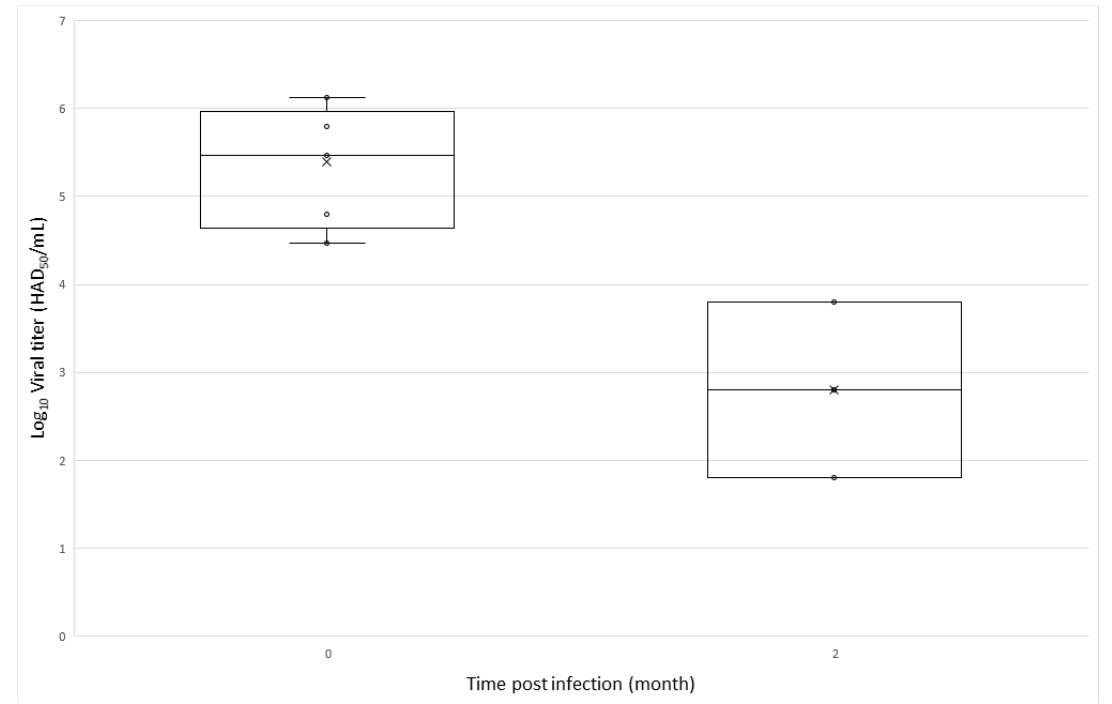
Figure 1. African swine fever viral titer of the soft ticks frozen at 0 and 2 months post infectious blood meal (10 ticks/group). Table 1. Pig infection by ingestion of infected ticks at zero and two months post-infection or “virus spiked brioche